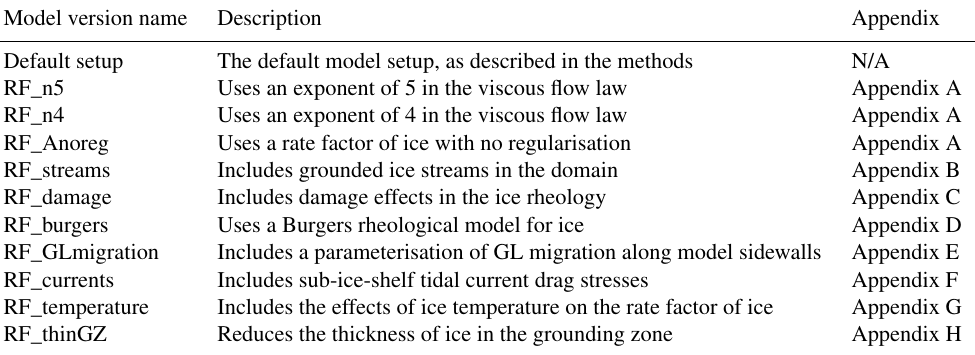
Table 1. Overview of the various model versions, including a brief description of how each one differs from the default setup and the relevant appendix in which more details can be